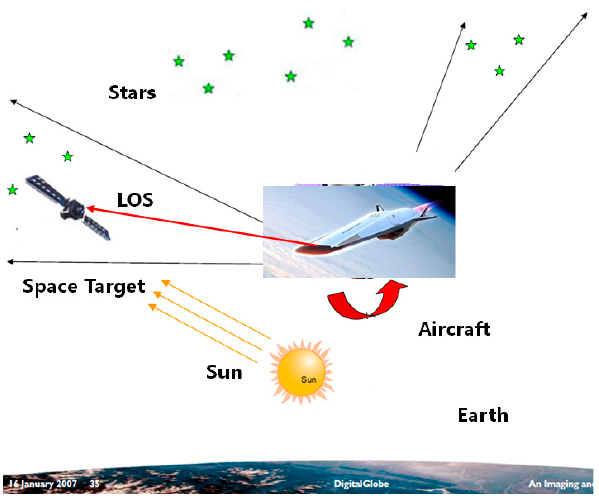
Figure 1. The measurement of the space target LOS vector.